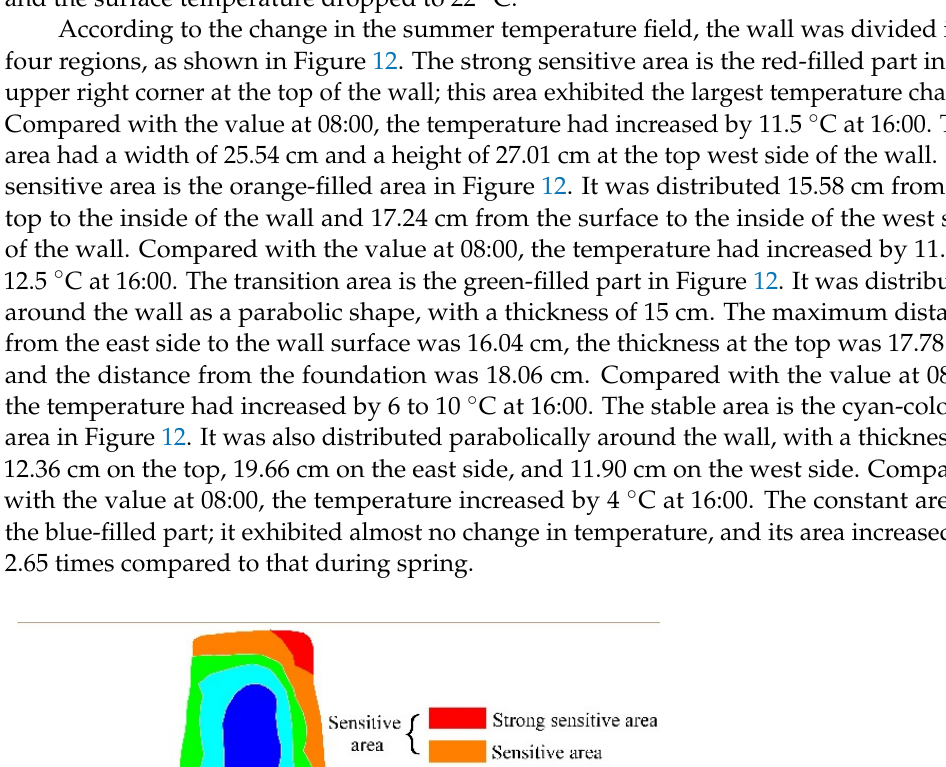
Figure 13. Selection of optimum days for autumn illumination. ( a ) 00:00